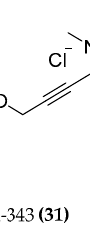
Figure 12. Structures of McN-A-343.